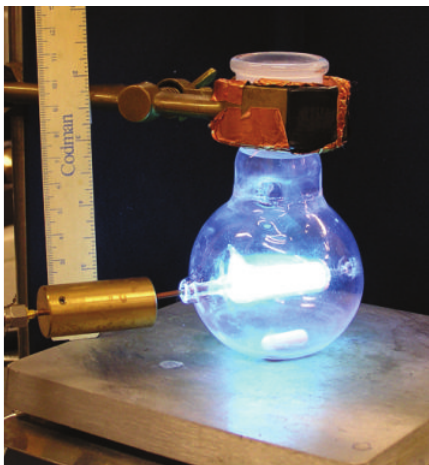
Figure 1: The MW/UV photoreactor. The quartz single-neck round flask, 200mL capacity, houses the bulb. The recess in the bulb, which houses the coaxial antenna, consists of a quartz tube of internal diameter 3 mm and outer diameter 5mm. The coaxial antenna is equipped with a cylindrical choke made of brass, with the length of 40 mm and external diameter of 20 mm.